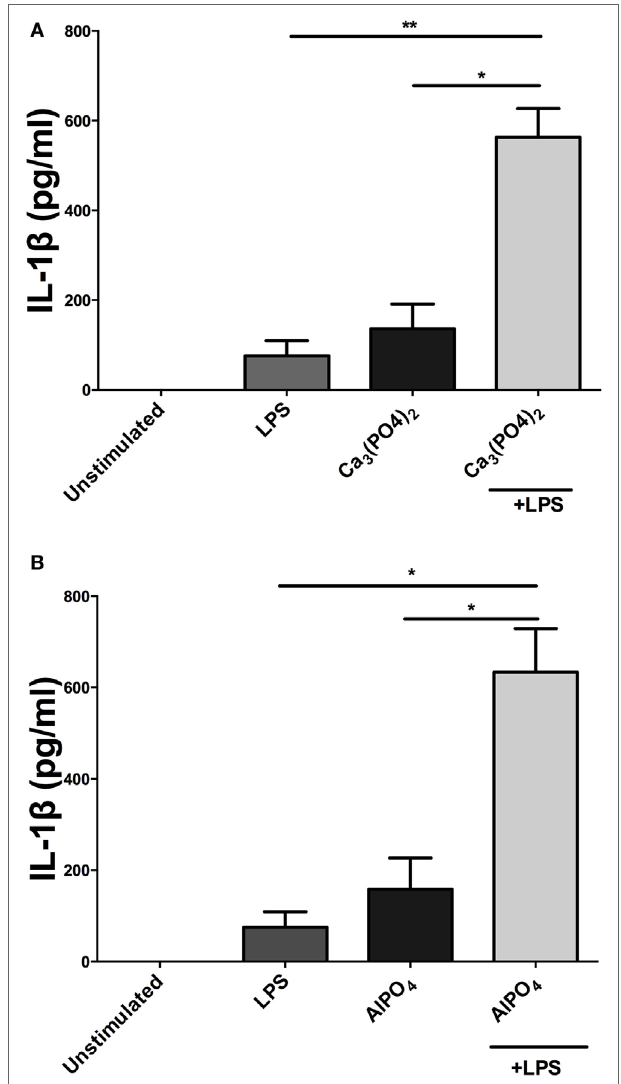
FigUre 2 | Calcium phosphate and aluminum phosphate adjuvants enhance IL-1 β secretion by bovine peripheral blood mononuclear cells (PBMCs). Cells (0.625 × 10 6 cells/ml) from three animals were stimulated with RPMI, LPS, and/or calcium phosphate (a) or aluminum phosphate (B) for 24 h and supernatants were tested for IL-1 β using ELISA. PBMCs were primed with LPS (10 ng/ml) for 3 h before cells were stimulated with adjuvants over a range of concentrations for 24 h. For ELISA analysis, results are mean cytokine concentrations ( + SEM) in supernatants that were tested individually in triplicate. * p < 0.05 and ** p < 0.01 were calculated using